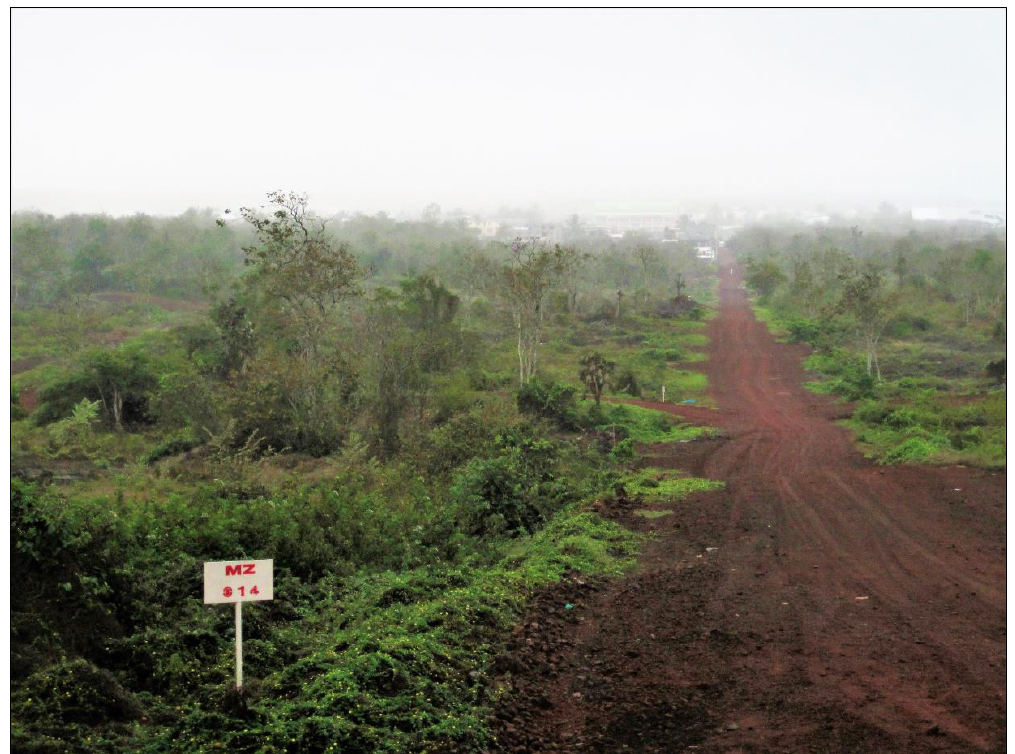
Figure 1. El Mirador, 2013. Photo by author.